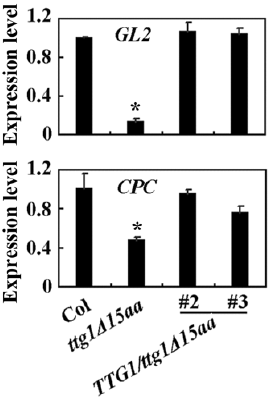
Figure 7. Expression of GL2 and CPC in the Col wild type, the ttg1Δ15aa mutant, and the TTG1 / ttg1Δ15aa transgenic plants. RNA was isolated from 10-day-old seedlings and qRT-PCR was used to examine the expression of GL2 and CPC . The expression of ACT2 was used as an inner control. The expression level of GL2 or CPC in the Col wild type was set as 1. Data represent the mean ± SD of three replicates. *, Significantly different from that in the Col wild type (Student’s t test, p < 0.01).